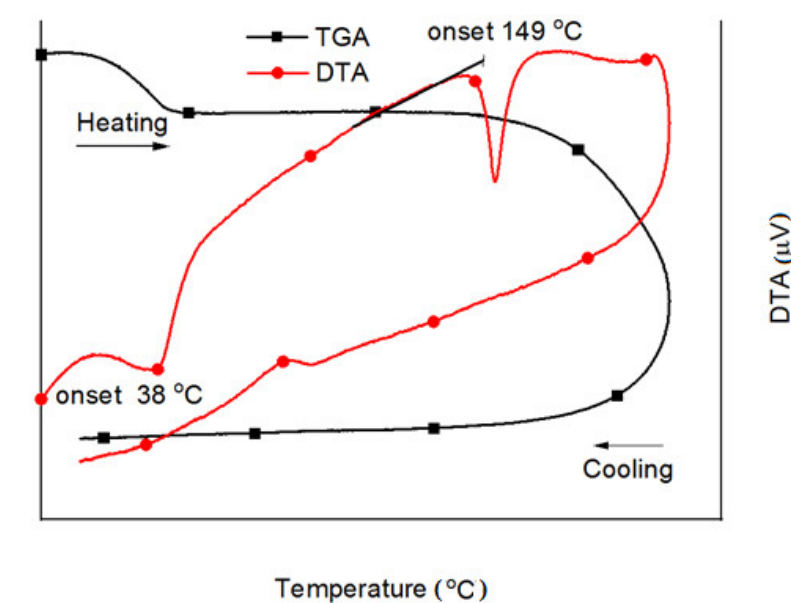
Figure 9. Di ff erential thermal analysis (DTA)-TG curves for Figure 9. Differential thermal analysis (DTA)-TG curves for glycyl-rimantadine.